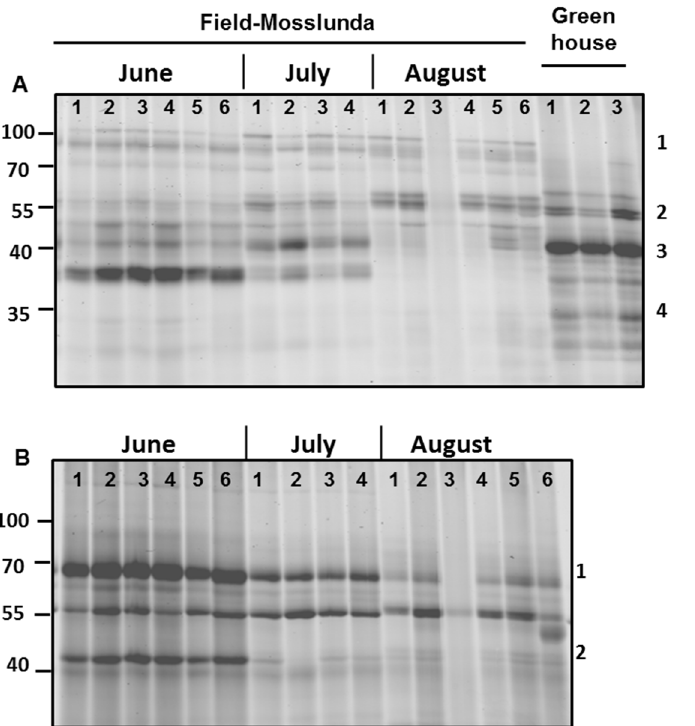
Figure 5. Serine hydrolase and β -glycosidase activity profiling of potato cultivar Bintje grown under greenhouse and field conditions in Mosslunda in June, July, and August 2012. Apoplastic proteins were labeled by 2 µM probe for ( A ) serine hydrolase and ( B ) β -glycosidase. The probe-labelled proteins were separated on 12% sodium dodecyl sulfate-polyacrylamide electrophoresis gels and detected using a fluorescence scanner.